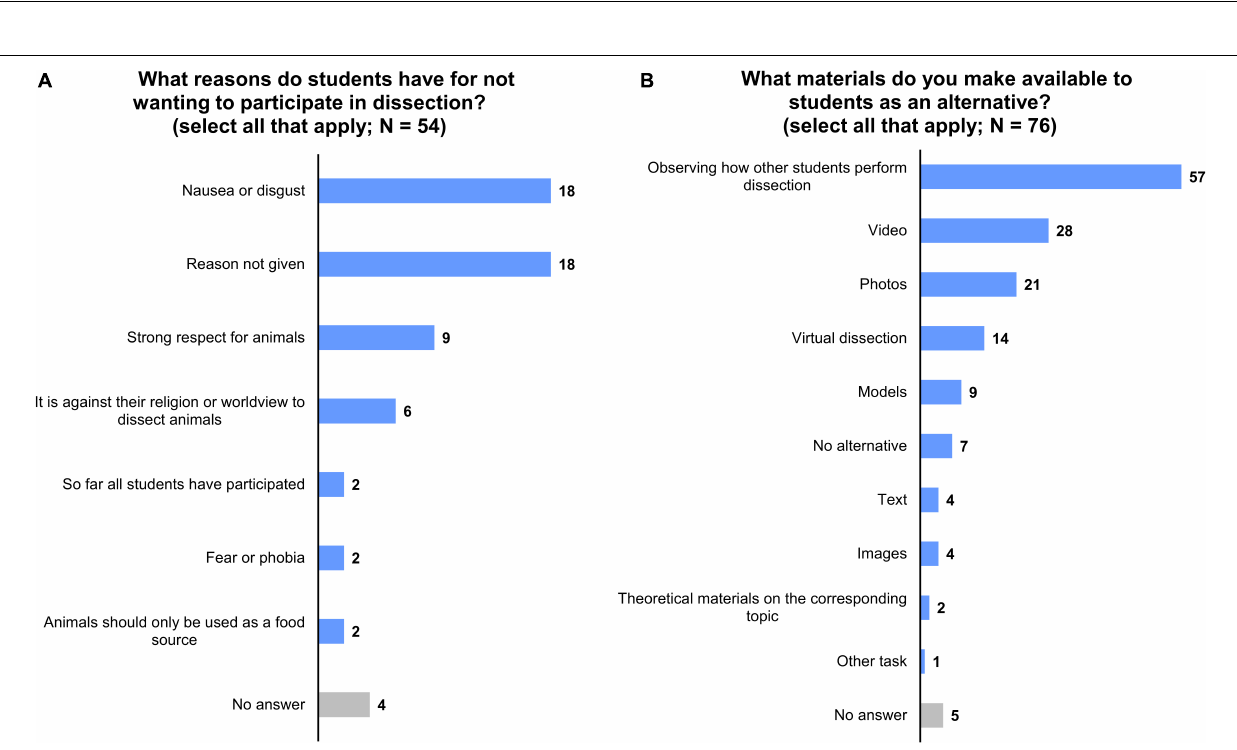
Frontiers in Education |